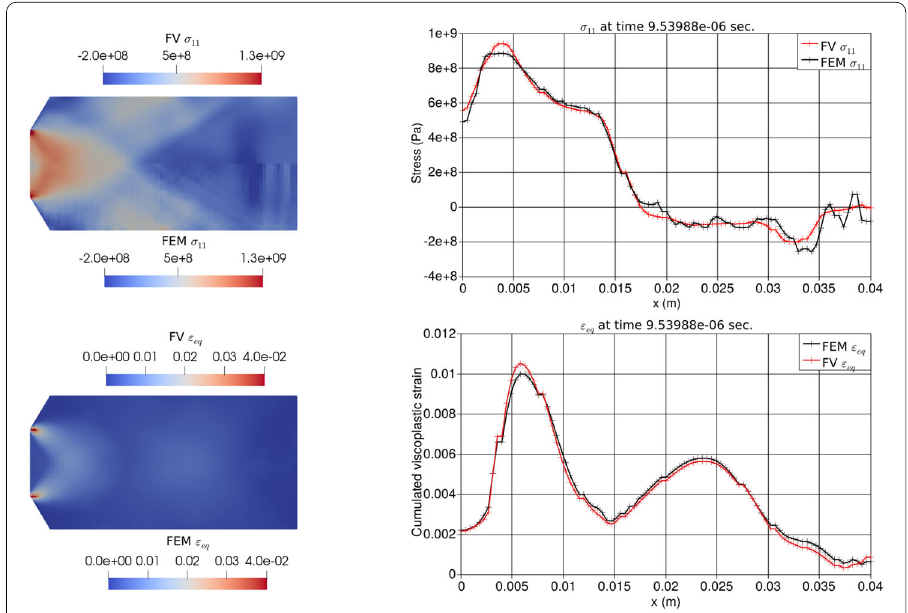
Fig. 17 Normal stress σ 11 and cumulated viscoplastic strains ε eq at time 9 . 54 × 10 − 6 s, computed with finite elements (bottom-half domain) and finite volumes (top-half domain). Superposed plots are made along the horizontal symmetry